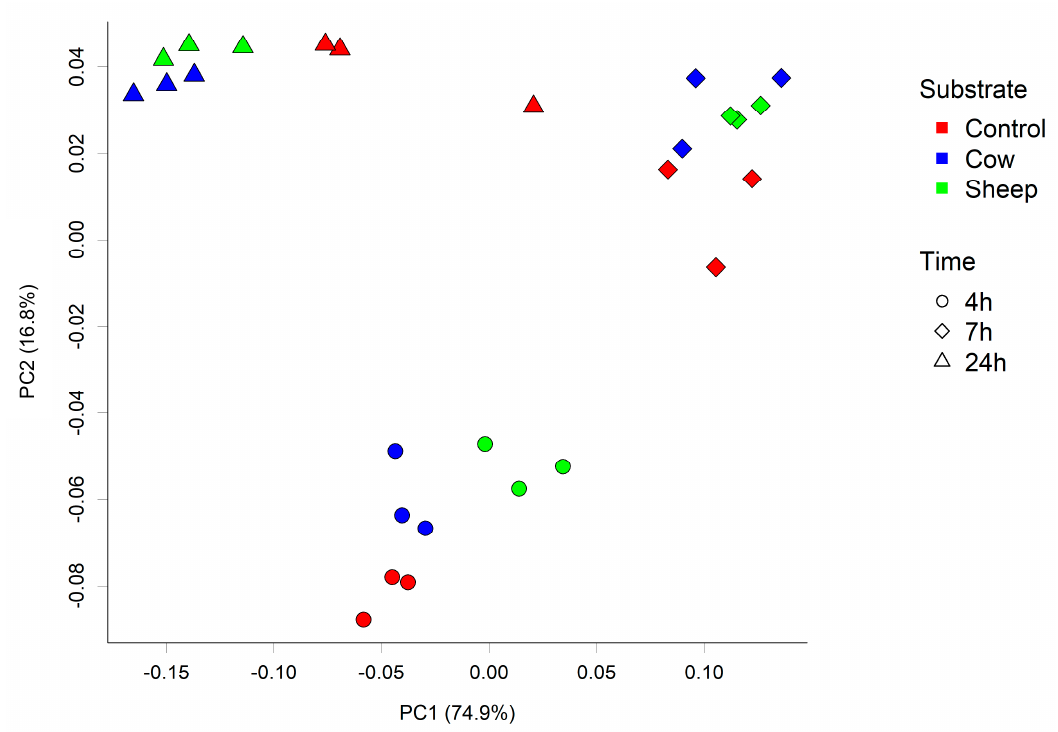
Figure 3. Principal coordinate analysis (PCoA) plot of the fecal microbial community from one-month-old child cultured with cow or sheep milk over 4, 7, and 24 h. PC1 and PC2 refer to principal coordinates 1 and 2 respectively.